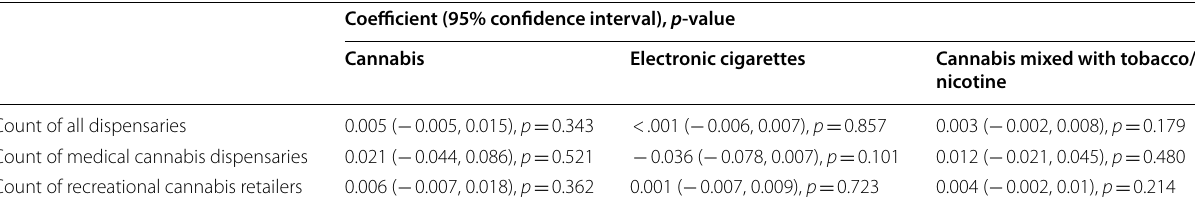
Table 2 Medical and recreational cannabis outlets within 5 mi and individual intentions to use (full sample, n